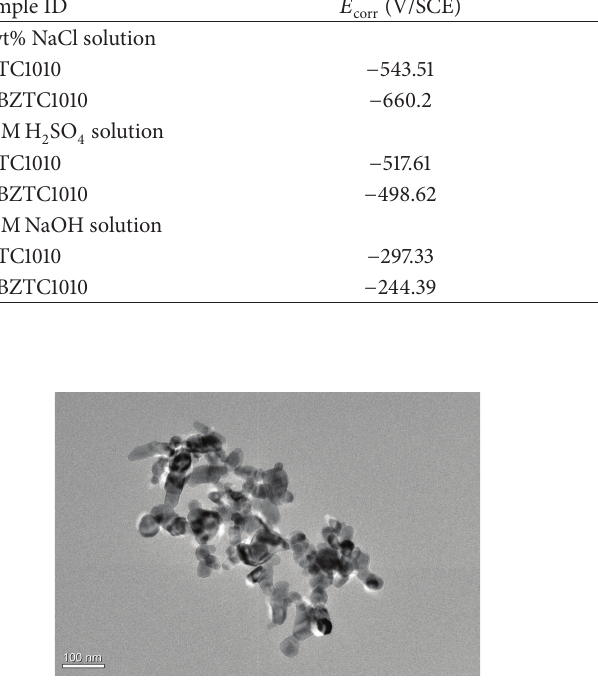
Figure 2: TEM images of the nanocrystalline Beta zeolite.